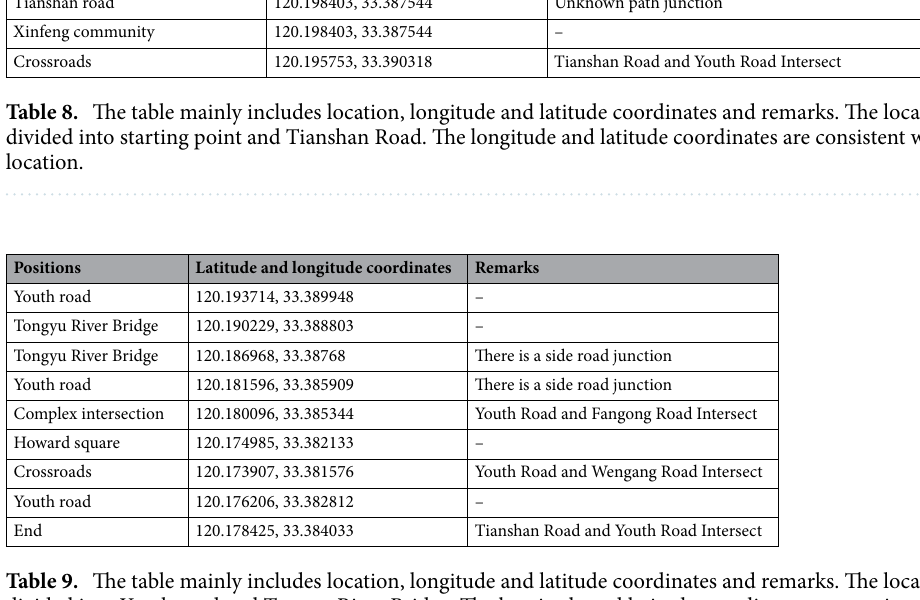
Table 9. The table mainly includes location, longitude and latitude coordinates and remarks. The location is divided into Youth road and Tongyu River Bridge. The longitude and latitude coordinates are consistent with the